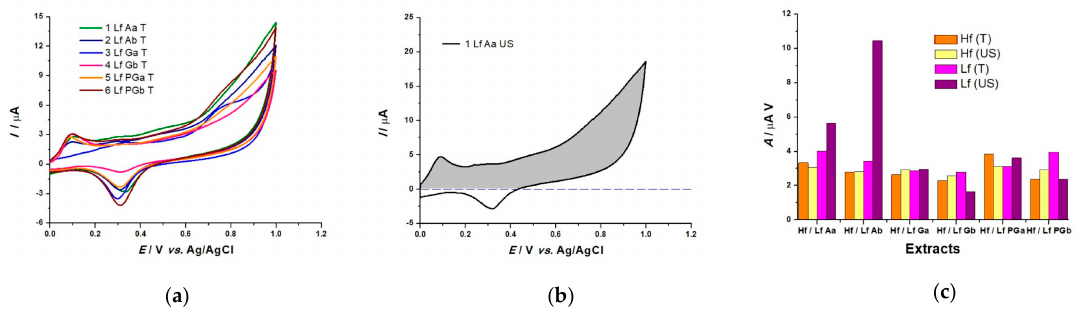
Figure 5. ( a ) Cyclic voltammograms, sweeping potential 0-1V, in 0.1 M NaPB, pH = 7.0, ν = 50 mV s − 1 for all pressure extracted lavender extracts; ( b ) Calculation of the anodic area and ( c ) Histogram showing all areas.